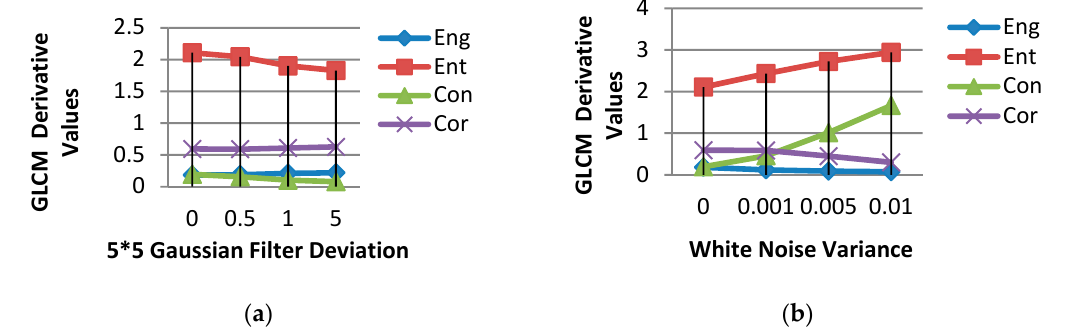
Figure 6. The GLCM-derived statistics of distorted images. ( a ) presents the results of images distorted by Gaussian blur distortion; ( b ) presents the results of images distorted by white noise distortion. As shown on the x -axis, four distortion levels were set for each distortion type.